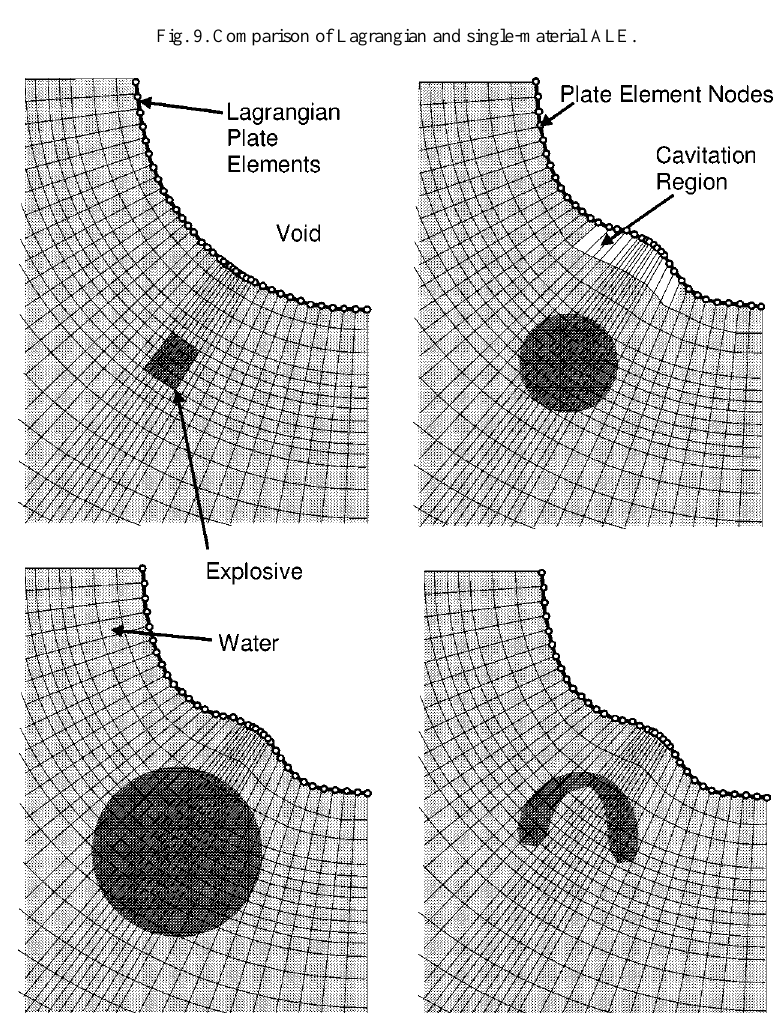
Fig. 10. Multimaterial ALE hydrocode UNDEX-SMI